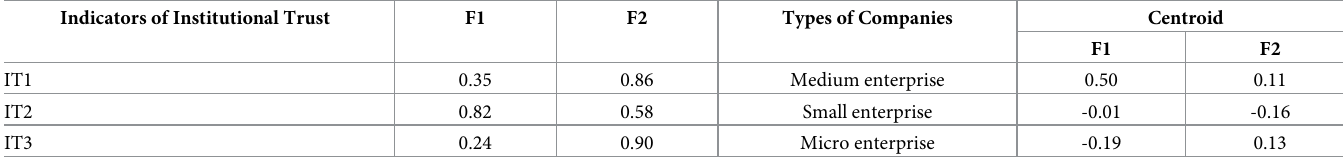
Table 6. Structure matrix and centroids’ discriminant factors of institutional trust.